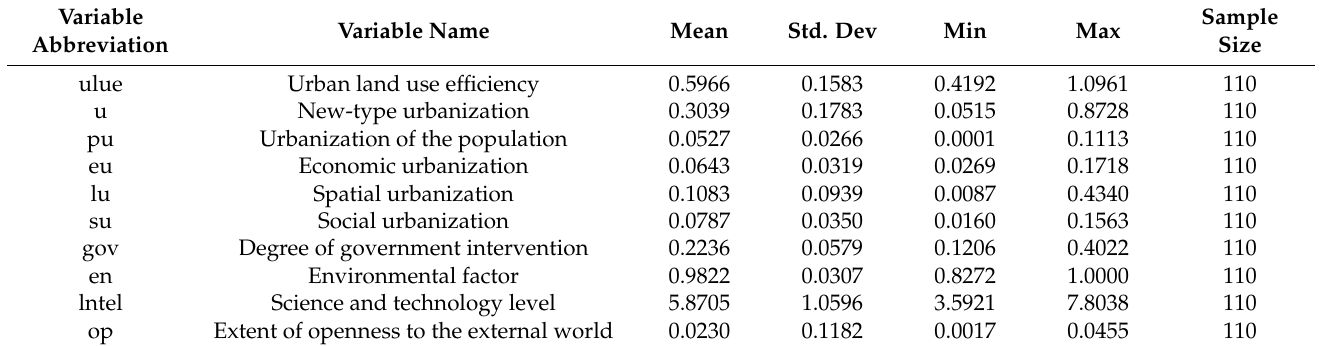
Table 3. Descriptive statistics of